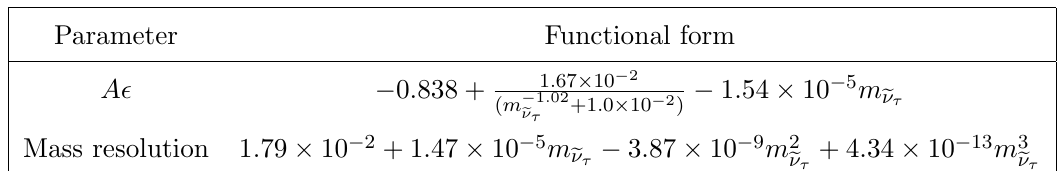
Table 2 . Parametrization functions for the product of the acceptance and e(cid:14)ciency, and for the invariant mass resolution for the RPV signal. The value of m functions are shown in (cid:12)gures 7 and 8 in the